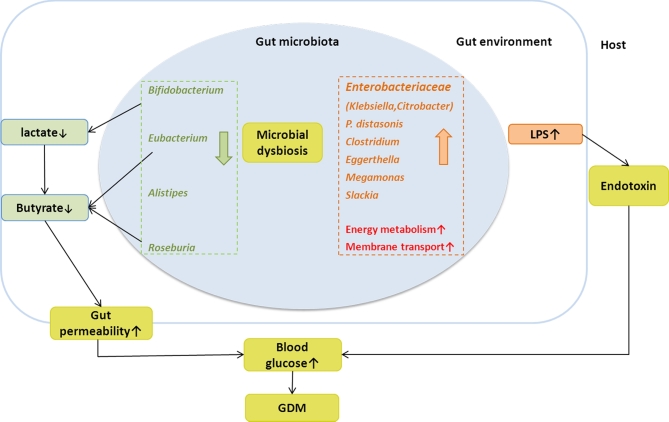
A schematic diagram showing the main bacteria and functions of the gut microbes that had a predicted GDM association. Red and orange columns and text denote enriched bacteria and their putative functions in GDM patients; green columns and text denote depleted bacteria and their putative functions in GDM patients.